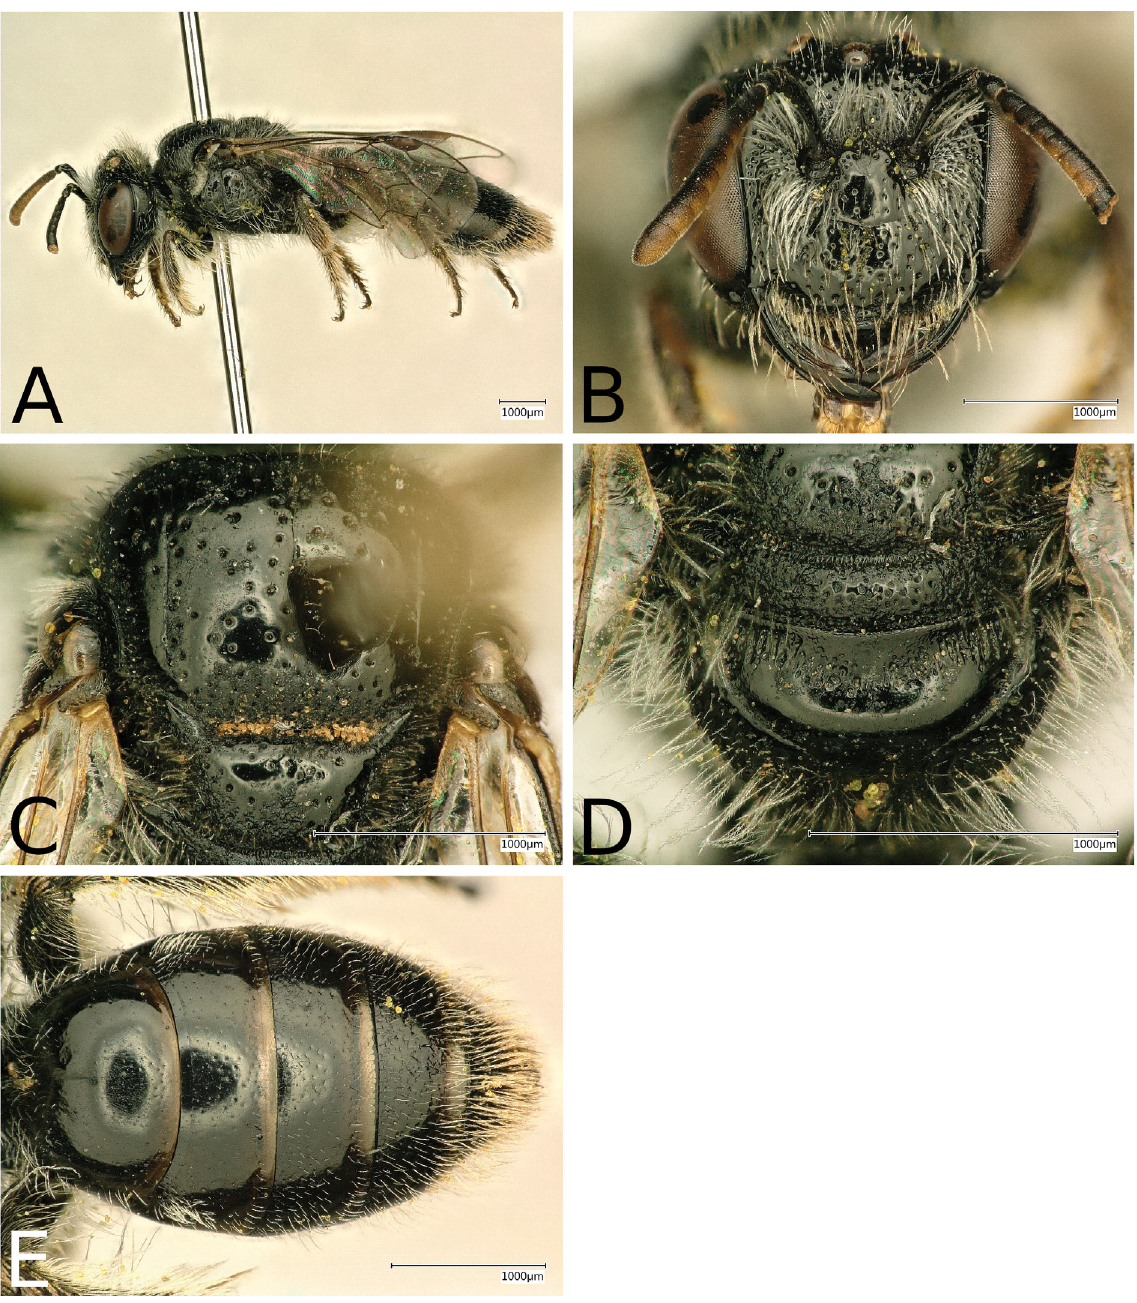
Fig. 8. Scrapter nitens Kuhlmann sp. nov., ♀, holotype (RCMK). A . Lateral view. B . Head. C . Scutum and scutellum (dorsal view). D . Metanotum and propodeum (dorsal view). E . Metasoma (dorsal